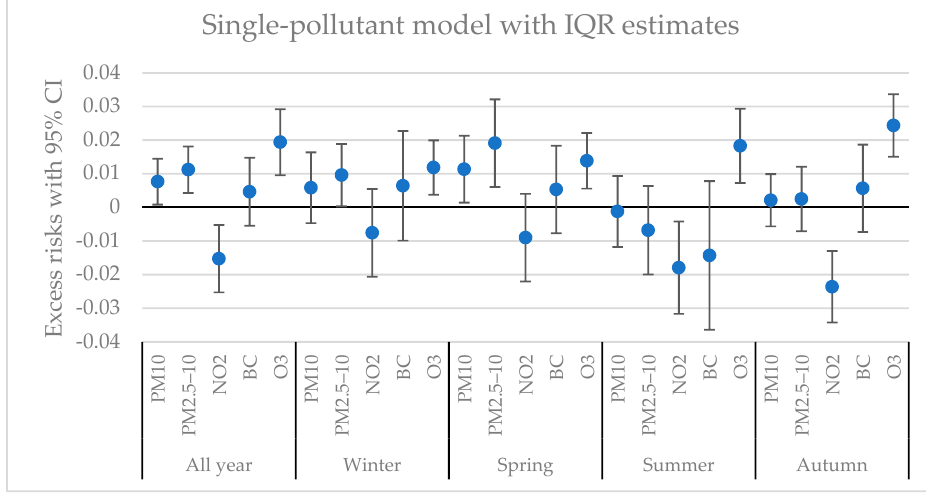
Figure 1. Estimated excess risks in daily mortality with 95% CI (lag02) for an IQR increase in the concentrations of PM 10 , PM 2.5–10 , NO 2 , BC and O 3 in single-pollutant models divided into all year and four different seasons.